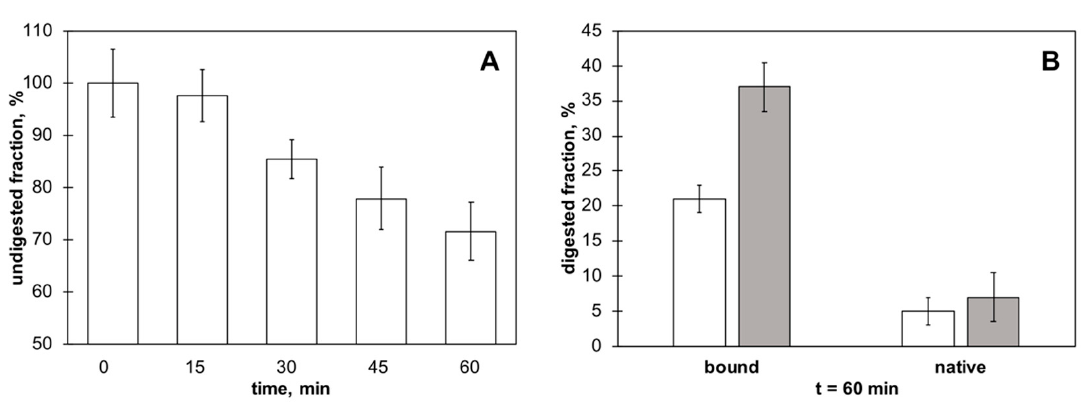
Figure 6. The adsorbed γ C’s sensitivity to trypsin and its constituent subunits. ( A ) A relative amount of γ C remained bound to the NPs over time; ( B ) the digested fraction of 30 kDa (white bars) and of 17 kDa (gray bars) subunits of γ C bound to NPs or alone after 60 min of incubation with trypsin. The possible variations of the biological properties of γ C have been assessed by checking the possible inflammatory / anti-inflammatory properties of the transfetted Caco-2 cells variations. The results are shown in Figure 7.